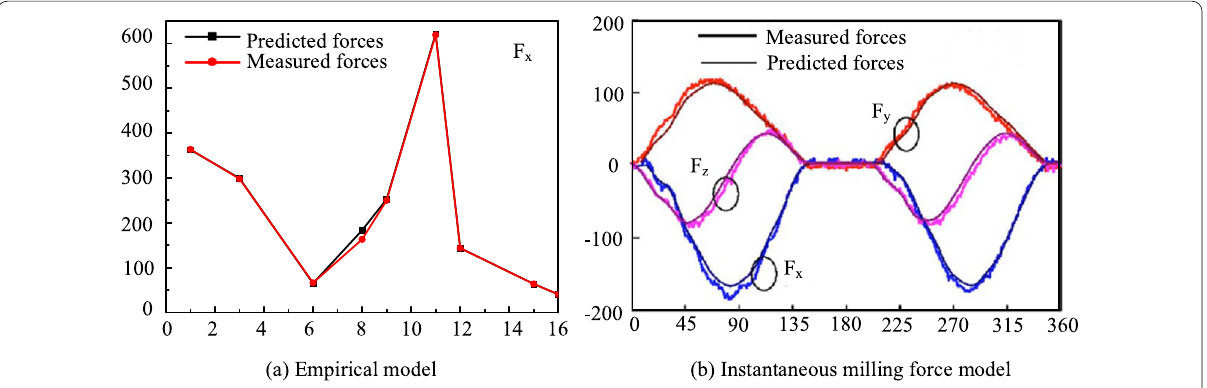
Figure 23 The predictive data forms of empirical model and instantaneous milling force model